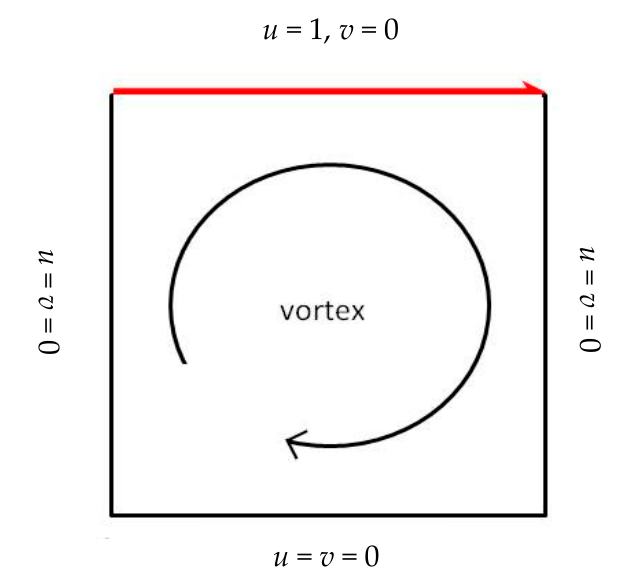
Figure 6. Sketch of a cavity domain with a constant speed at the lid.